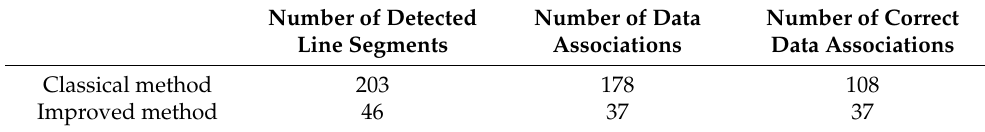
Table 1. Results of using different methods to associate the data of line segments. Number of Detected Number of Data Number of Correct Line Segments Associations Data Associations Classical method 203 178 108 Improved method